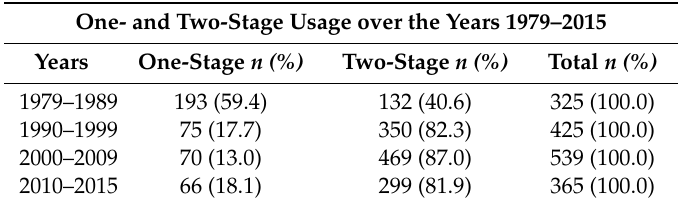
Table 2. The one- and two-stage revision utilization from 1979–2015.